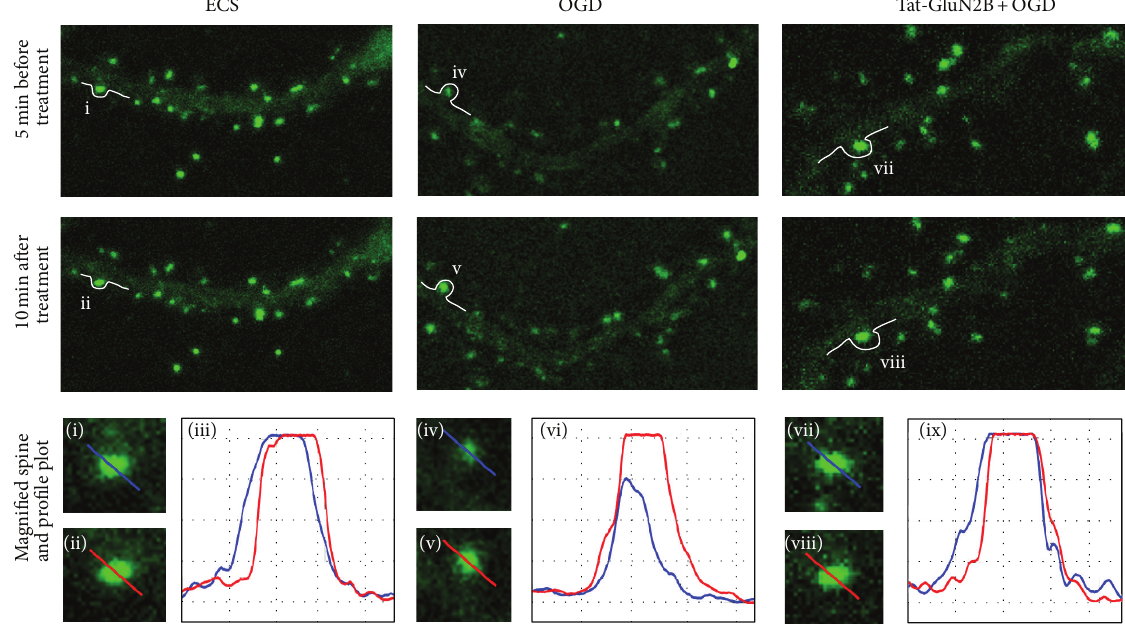
Figure 6: The expression of NMDAR at spine was induced by OGD 2min treatment and suppressed by Tat-GluN2B incubation. SEP-GluN1 transfected neurons were incubated with Tat-GluN2B for 15min or not. Subsequently, imaging was performed on 5 min before (first row) and 10min after (second row) ECS (as control) or OGD 2min treatment. Magnified images were corresponding to the spines denoted by lowercase Roman numerals ((i), (ii), (iv), (v), (vii), and (viii)). Profile plots were corresponding to the blue and red lines in their left two magnified images ((iii), (vi), and